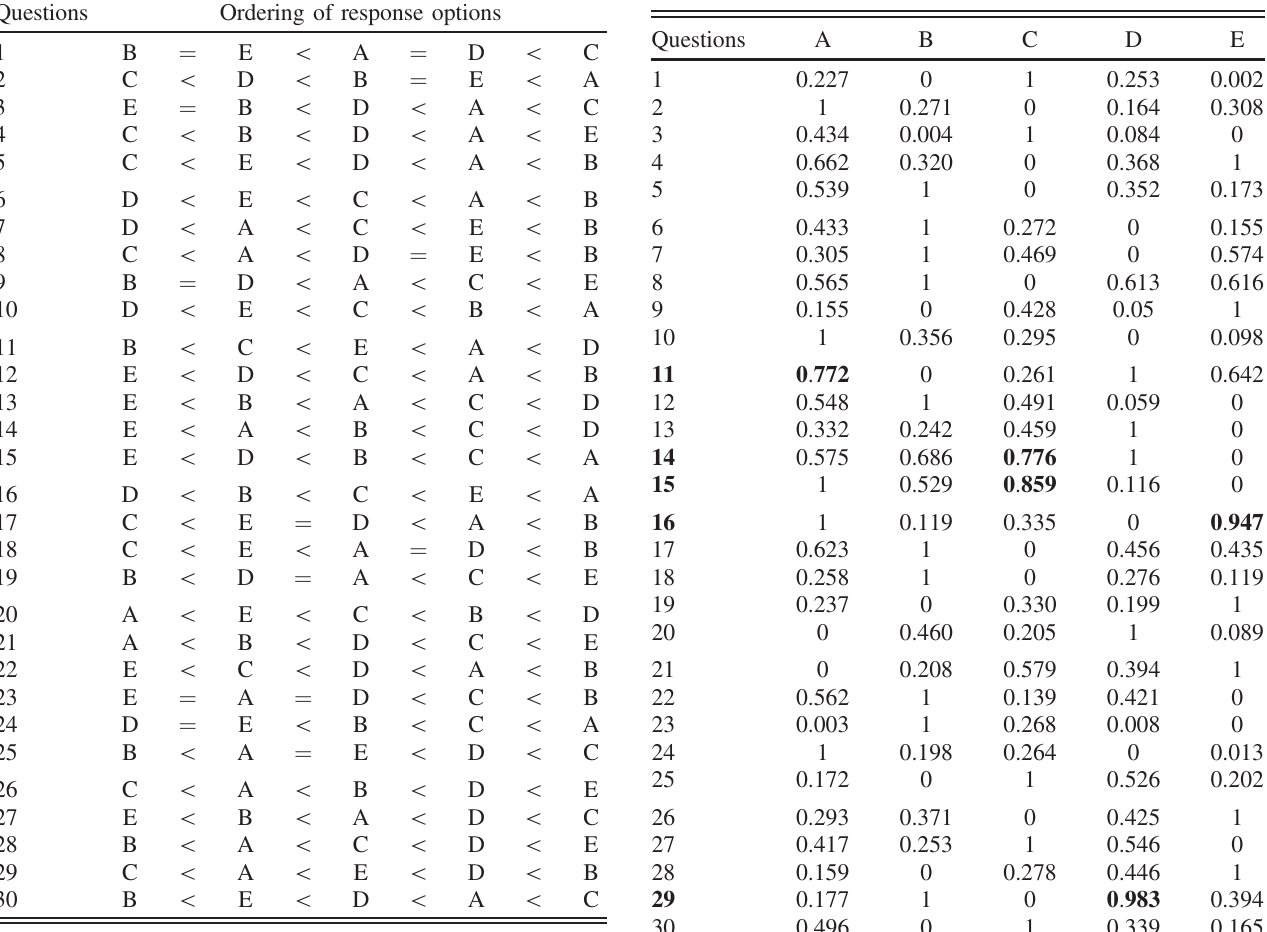
TABLE II. The partial credit scoring model generated from the ak values given in Table III in the Appendix. Questions in bold font are ones that are potentially malfunctioning with distracting options having partial credit scores greater than 0.75, and are discussed in Sec. V